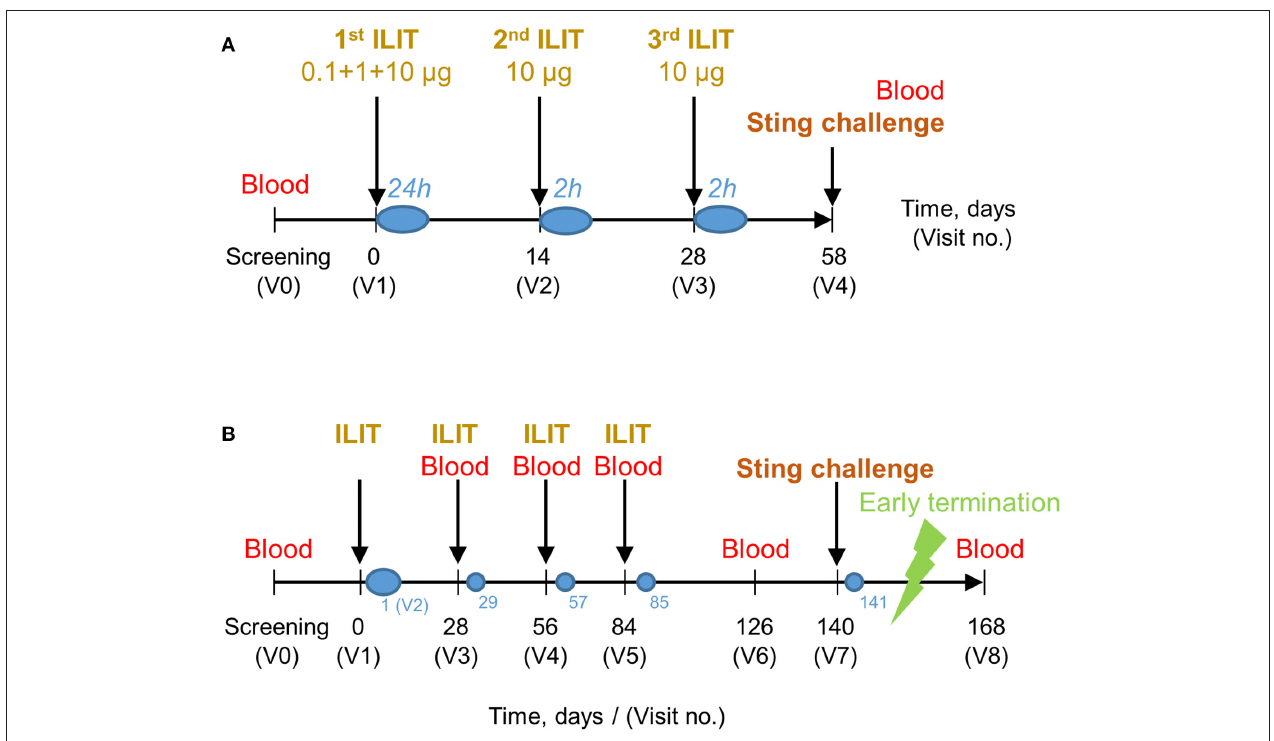
FIGURE 1 | Time scheme of pilot (A) and randomized (B) bee venom intralymphatic immunotherapy (ILIT) studies. (A) After screening (V0), patients in the pilot study attended a first visit (V1, day 0) where they received the first injections of aqueous bee venom in doses of 0.1, 1, and 5 µ g with 30-min intervals, followed by 5 µ g of aluminum hydroxide-absorbed bee venom. During the second (V2) and third (V3) injection visit, 5 µ g of aluminum hydroxide-absorbed bee venom was injected with 30-min intervals. The total cumulative dose was 31.1 µ g. After each visit, patients were observed at the intensive care unit or the normal ward for 24 or 2h (blue circles). At the screening visit (V0) and on day 58 (V4), venous blood was drawn and a honeybee sting challenge was performed. (B) Following the screening visit (V0) of the randomized study, patients in the randomized study attended a first visit (V1, day 0) where they received bee venom ILIT injections: 0.1, 1, and 10 µ g 30min apart, provided no systemic signs or symptoms. Visit 2 was a safety follow-up 1 day after visit 1 (blue circle). At visit 3, treatment group 1 received one 10- µ g dose and treatment group 2 received two doses of 10 µ g 30min apart. At visits 4 and 5, one treatment group received 10 µ g and the other group received 20 µ g in a single dose. The total cumulative doses were 41.1 and 71.1 µ g. Blood was drawn at screening and at every visit from visit 3 onward as to measure bee venom-specific immune responses. A deliberate bee sting challenge was performed at visit 7. Visits 3, 4, 5, and 7 were followed up for safety 1 day later by telephone (small blue